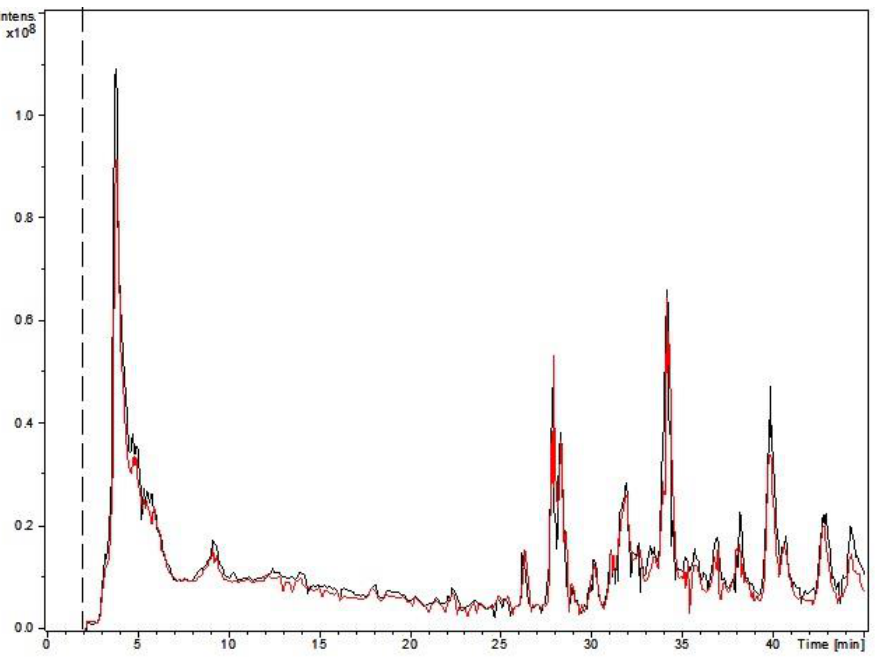
Figure 3. A comparison between samples of the same strain grown under the same conditions and extracted in ethanol. The perfect overlap of the different extracts confirms the reliability and reproducibility of the extraction and analytical methods.